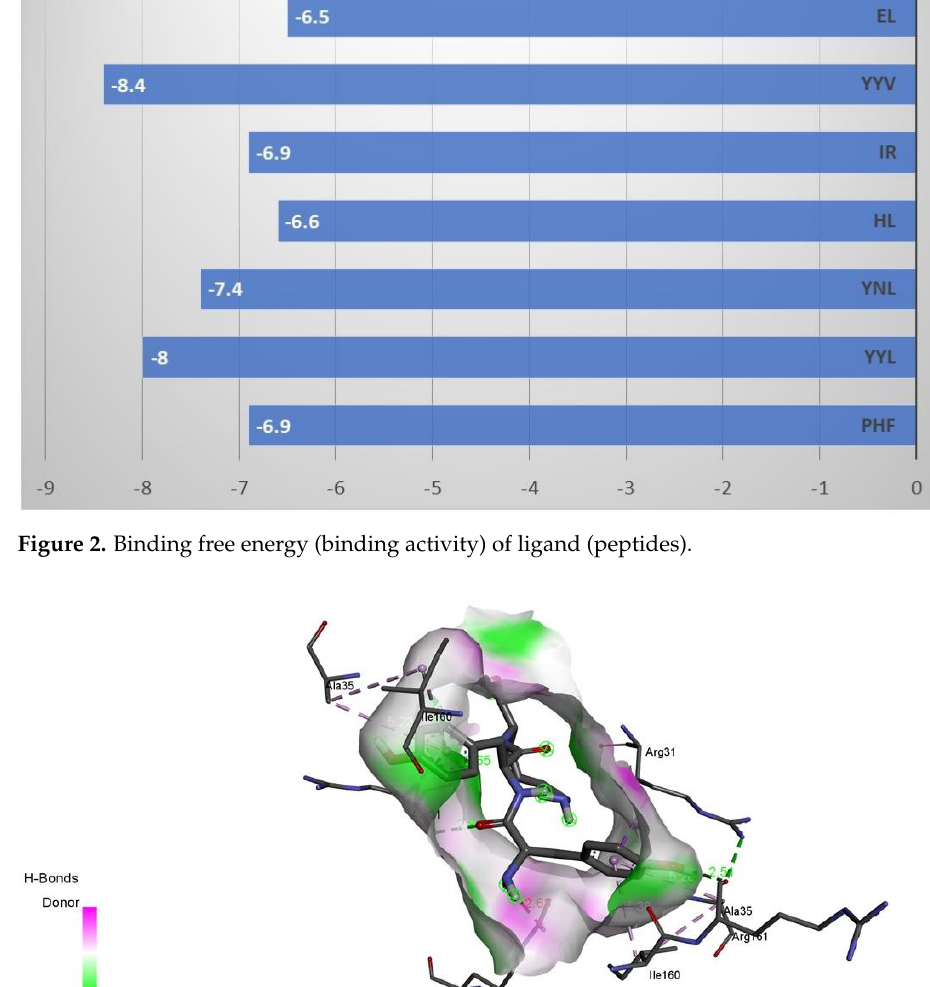
Figure 2. Binding free energy (binding activity) of ligand (peptides).